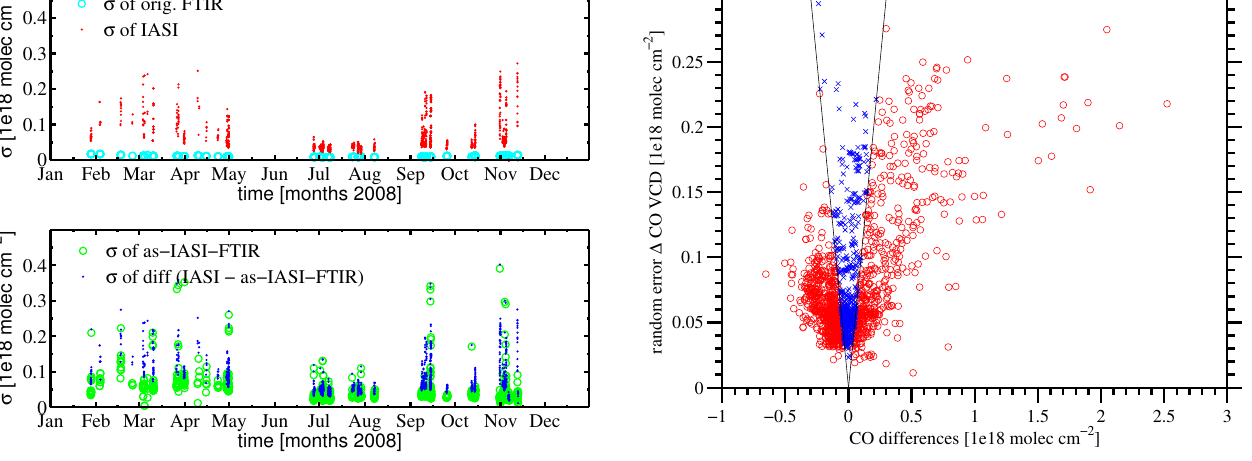
Fig. 6. Carbon monoxide random errors, σ , for the quality-filtered data against time at Kiruna. Shown are the errors for the original FTIR total columns (cyan open circles), the IASI total columns (red dots), the as-IASI-FTIR total columns (green open circles) and the random errors of the differences between IASI and as-IASI-FTIR total columns (blue dots).